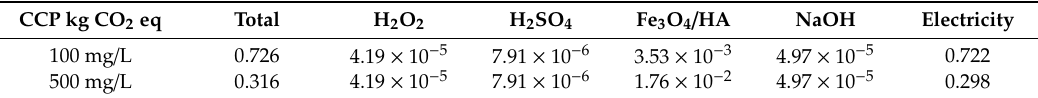
Table 8. Comparison of the climate change potential (kg CO 2 eq) results of the degradation process of 90% of 20 µ M BPA in 1 L of water, between the processes conducted using a catalyst concentration of 100 and 500 mg / L, with the pH and oxidant concentration being pH 3 and hydrogen peroxide (1 mM)